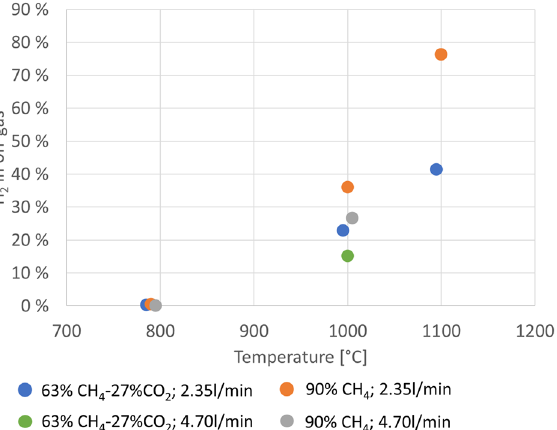
Figure 3. Hydrogen content in the off gas of all experiments, plotted versus temperature. For repeat experiments, each data point represents an average of all experiments with identical experimental parameters. The data points at common temperatures have been spaced out along the x-axis to improve readability. All data points have been recorded at T = 790 °C, 1000 °C or 1100 °C,